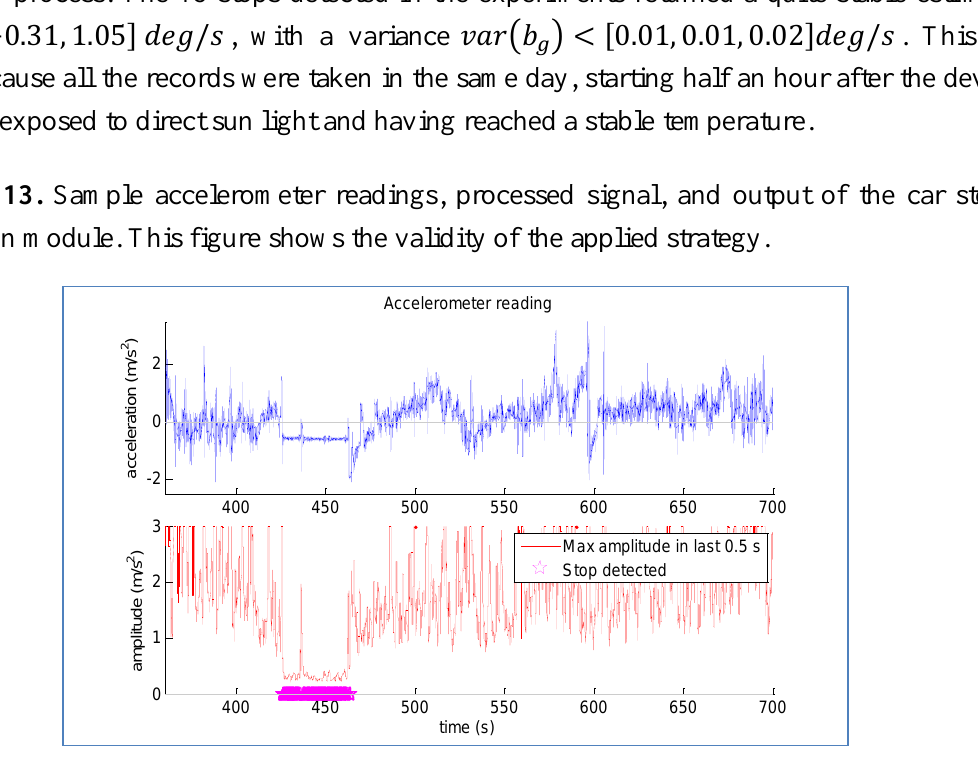
Figure 14. Output of the trajectory analysis module: straight movement detection using accelerometer